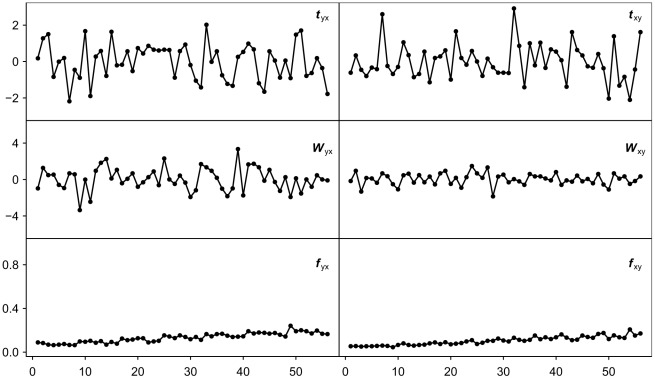
Granger Causality patterns between simulated ROIs.GC was computed from averaged voxel time series as t
yx and t
xy, and then normalized to z-scores, for a range of simulation models (top row). GC was also computed as voxel-based W (middle row) and f (bottom row) summary statistics computed directly from the parameters of the same simulation models (b values normalized to z-scores before computing W). The horizontal axis labels the 56 simulation models in the order of Table 1, representing different connectivity parameter settings. The t-scores do not significantly correlate with either W or f across simulation models, demonstrating that GC computed from averaged voxel time series is not sensitive to true connectivity.